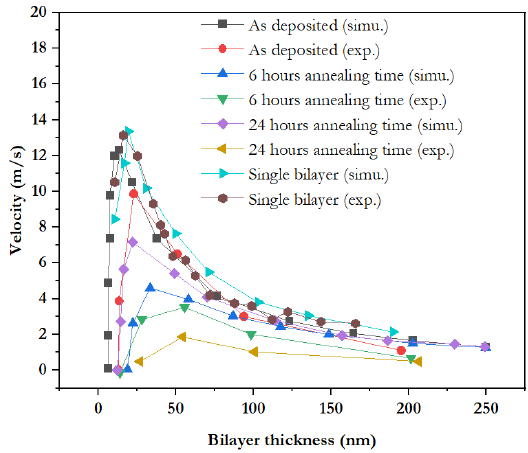
Figure 10. Variation of velocity with function of bilayer thickness of thin film, predicted and measured values [43] .